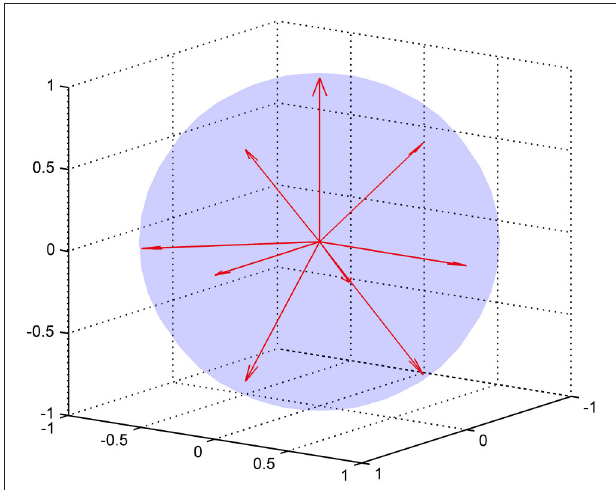
FIGURE 3 | The nine encoding directions required for fast DKI illustrated as unit vectors. The directions are listed explicitly in Table 1 .